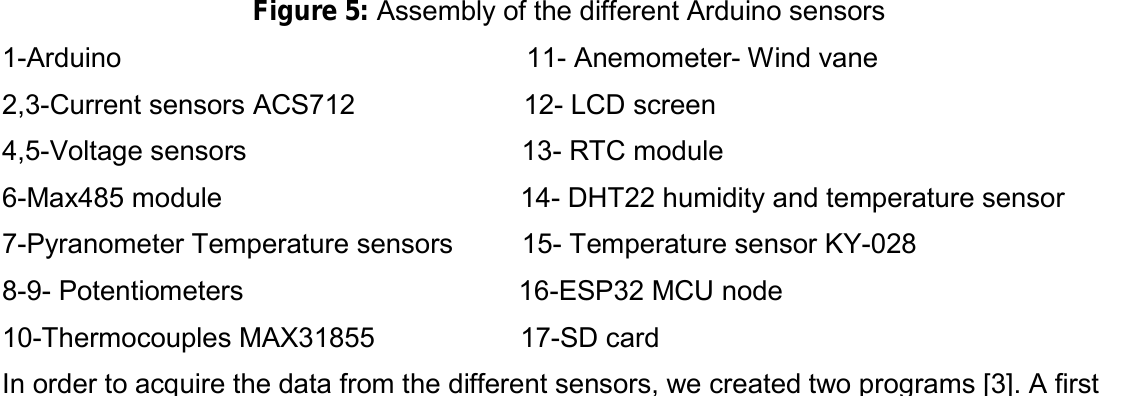
Figure 5: Assembly of the different Arduino